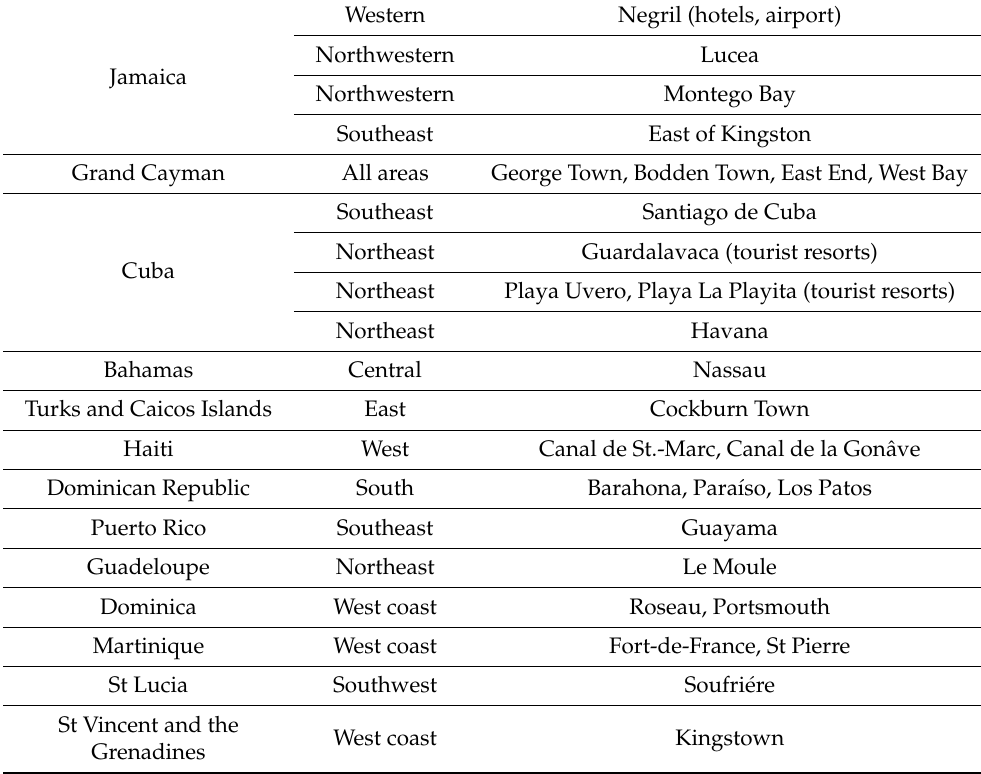
Table 3. List of sites with OTEC potential (1000 m depth at closer than 5 km to the coast) as well as being near towns or other